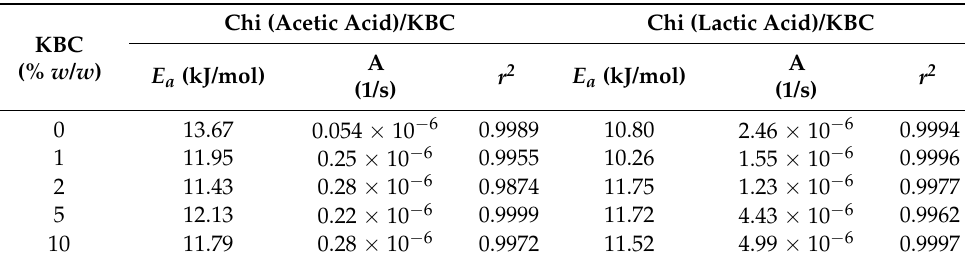
The parameters of Arrhenius equation of Chi solutions modified by KBC with different concentrations.